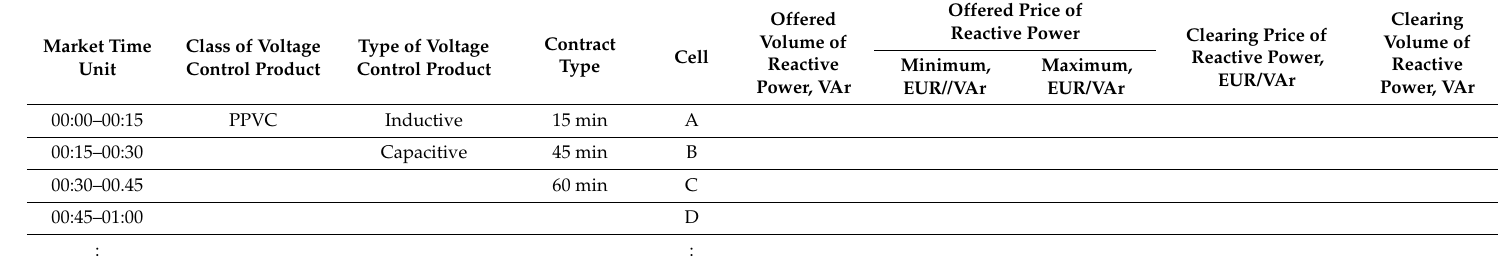
Table 3. Publication of aggregated data related to the trade in reactive